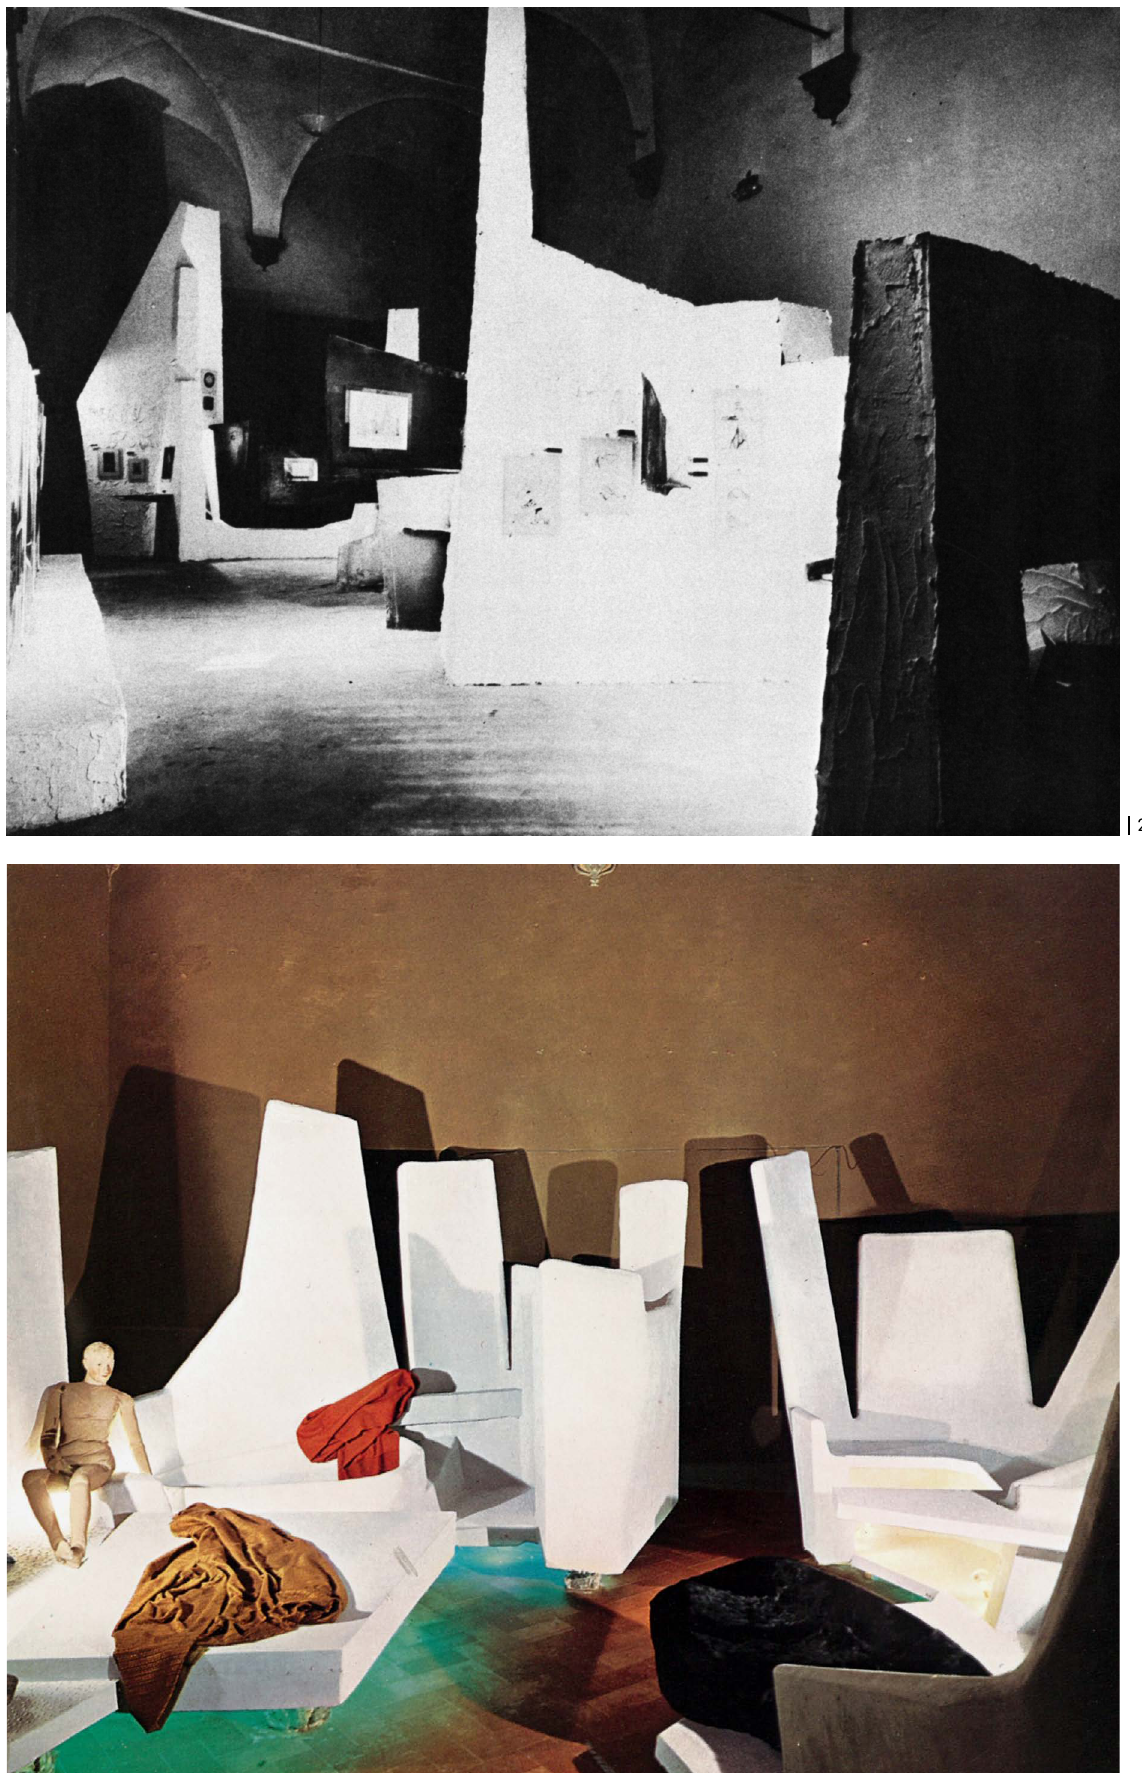
The model of the Ecclesia di Monte degli Ulivi photographed against the backdrop of the Fiesole hills. From Edilizia mod- erna , nos. 82-83